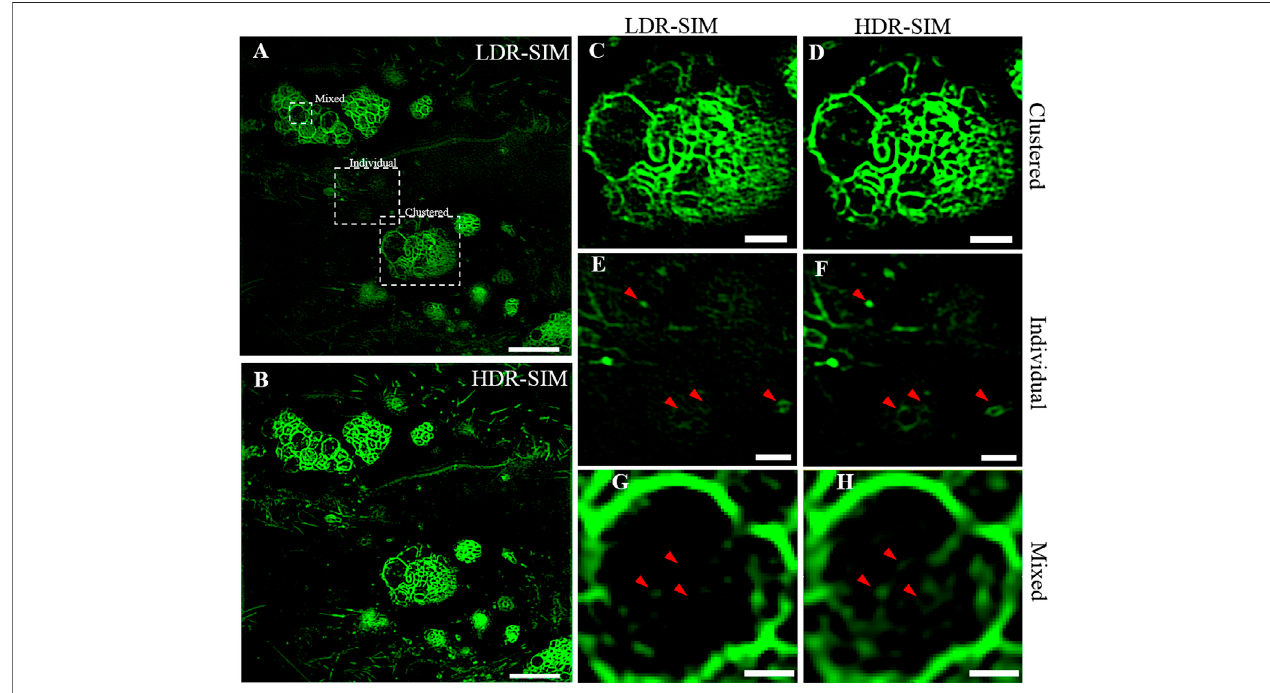
FIGURE4| Imagingofindividualandclusteredvesiclesinliveosteosarcomacells. (A) TheLDR-SIMimagingwithmiddleexcitationintensity. (B) HDR-SIMimaging ofthesamesample. (C,D) Zoomed-inviewofabrightregionshowingclusteredvesiclesbyLDR-andHDR-SIM. (E,F) Zoomed-inviewofadimregionshowingindividual vesiclesbyLDR- andHDR-SIM. (G,H) Zoomed-inviewofalargevesiclewithaninner structure byLDR-andHDR-SIM.Colormapsarescaled identically foreach pairof images. Scale bar: (A,B) 5 μ m, (C – E) 1.5 μ m, and (F) 0.5 μ m. Gamma value: 0.5 for images in (A,B) .